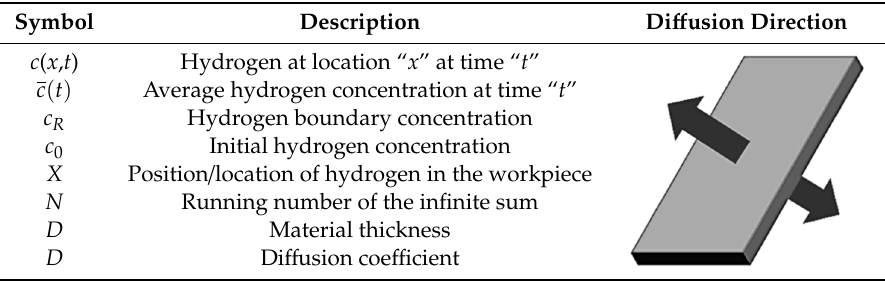
Table 1. List of variables for the di ff usion equations.